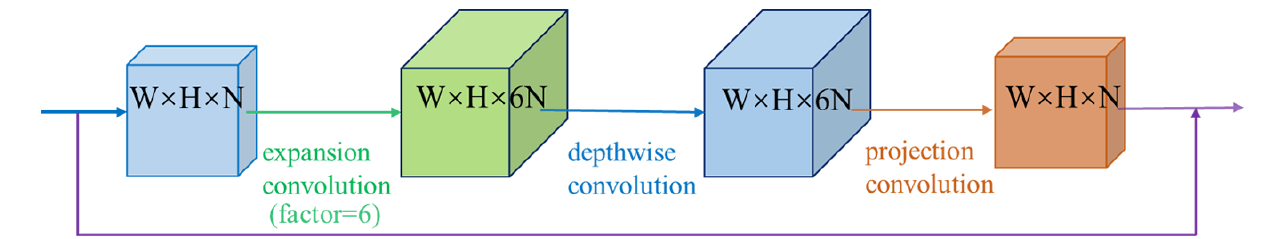
Figure 2. The structure of the inverted residual connection in MobilenetV2.